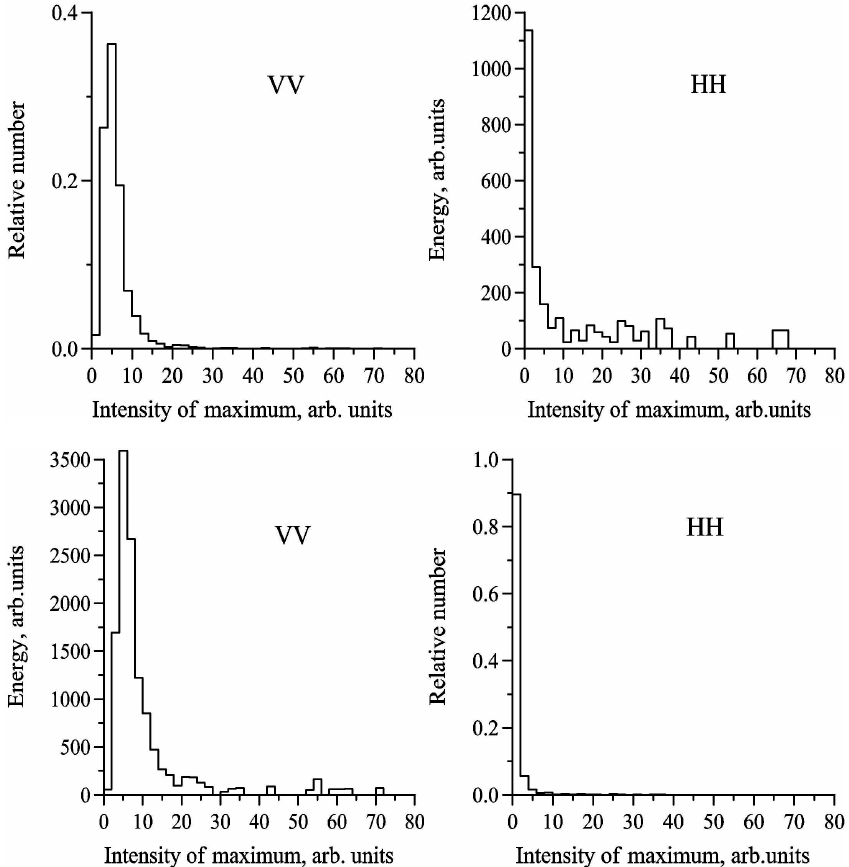
Figure 8. Histograms of local backscatter maxima ( top panels ) and distributions of total energy of local backscatter maxima within a given intensity interval vs. intensity of local backscatter maximum ( bottom panels ) at HH-polarization ( left column ) and VV-polarization ( right columns ). Wind velocity is 10 m/s, incidence angle 60 ◦